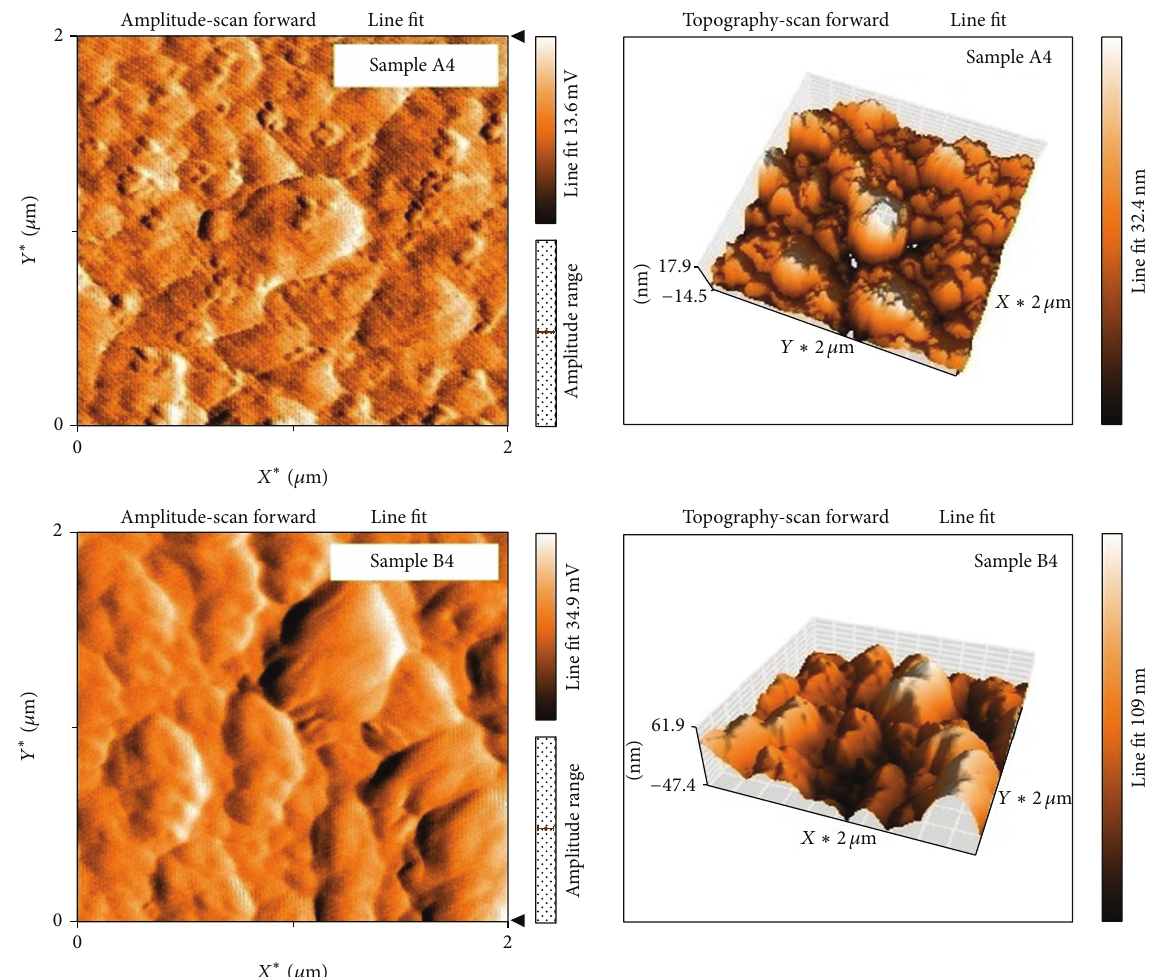
Figure 5: Surface morphology of sample A4 (grown at 370 ∘ C) and B4 (annealed at 460 ∘ C).